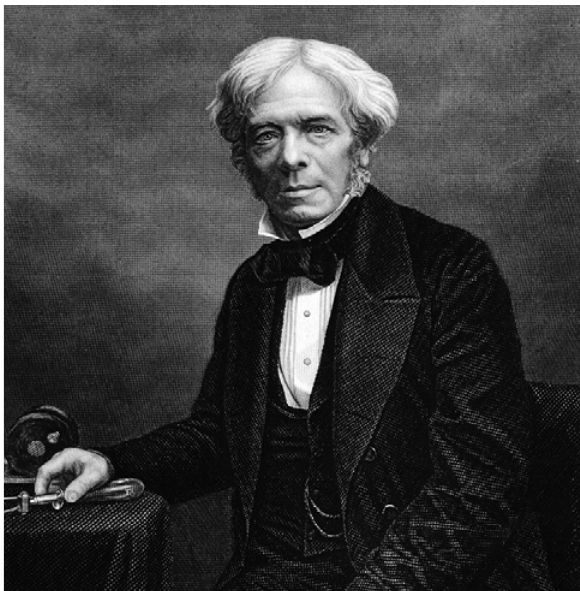
Figure 9. James Clerk Maxwell [12].